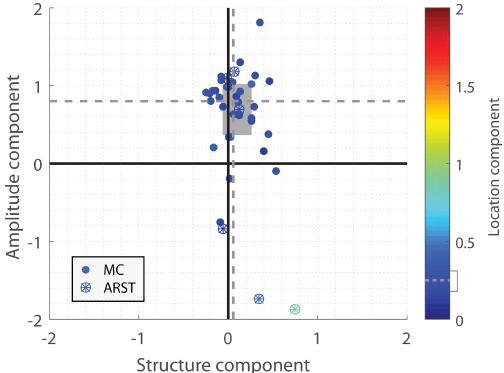
Figure 10. Structure–amplitude–location (SAL) analysis (Wernli et al., 2008). Each dot represents one event (classified according to Sect. 3.4). Dashed lines are median component values, and the grey rectangle represents the 25th–75th percentile range. The loca- tion component median value is 0.25, and its 25th–75th range is 0.18–0.31. More details are given in Sect. S2 in the